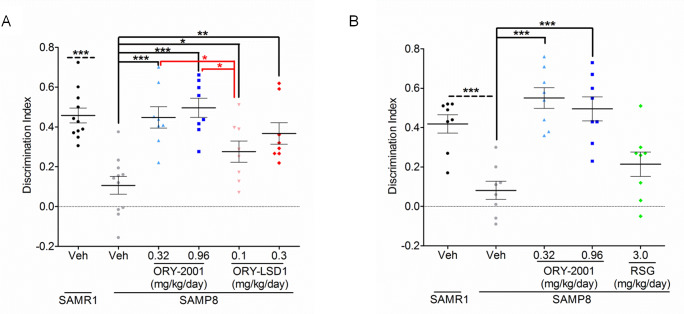
KDM1A inhibition is key for memory rescue by ORY-2001.(A) Comparison of the effect of ORY-2001 and ORY-LSD1 on the DI in the NORT reflects higher efficacy of ORY-2001 in SAMP8 mice (F4,38 = 10.40; p < 0.0001; Vehicle: N = 11/group; ORY-2001 and ORY-LSD1: N = 8/dose). (B) Comparison of the effect of ORY-2001 and RSG on the DI in the NORT reflects higher efficacy of ORY-2001 in SAMP8 mice (F3,28 = 16.84; p < 0.0001; N = 8/group).